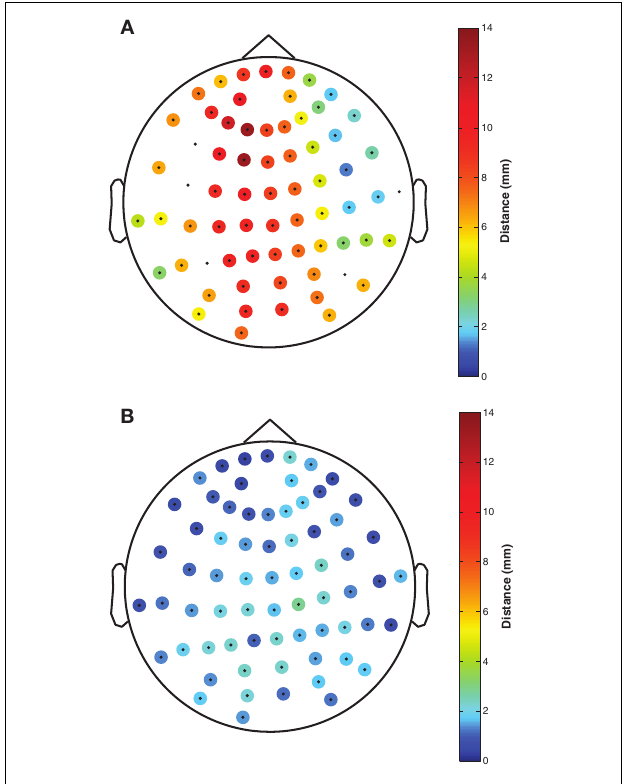
FIGURE 2 | The distance of (A) Fastrak and (B) FlyTri electrode coordinates, relative to the fringe projection coordinates taken as the gold standard, is indicated by colors at each electrode position. Coordinates rejected from the Fastrak dataset due to missing data or intermeasurement discrepancies greater than 10mm are shown with no color. The Fastrak coordinates had a mean deviation of 6.8mm, while the FlyTri coordinates had a deviation of only